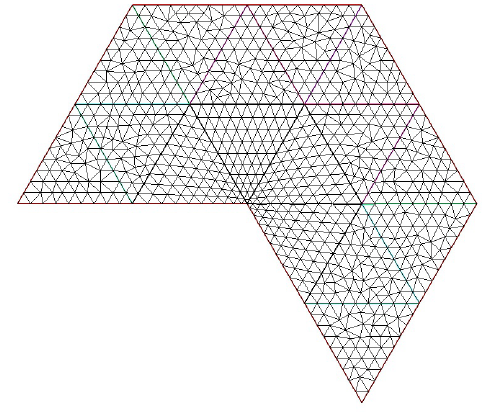
Figure 3. Adapted